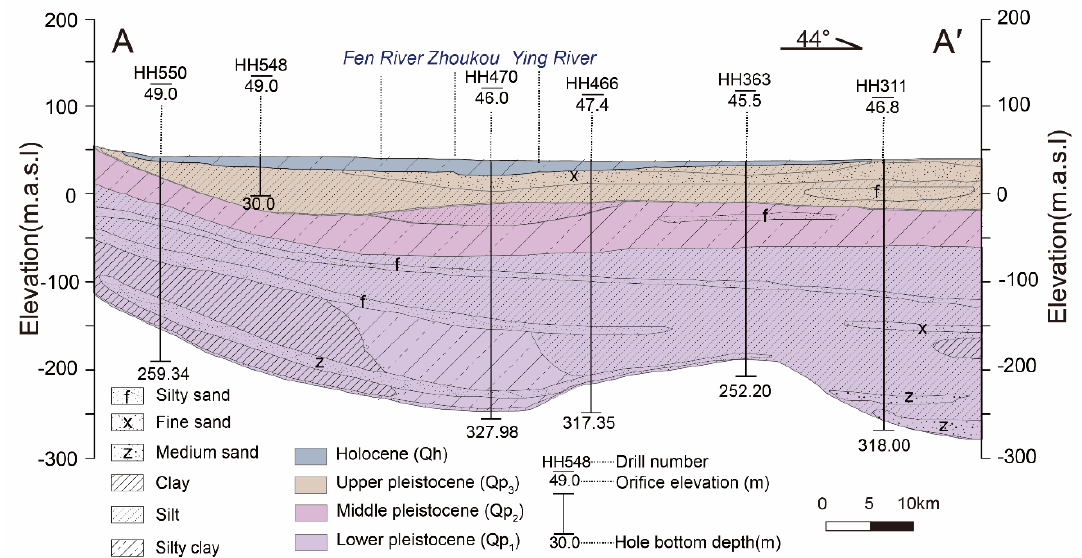
(cid:48) ) of the Shaying River